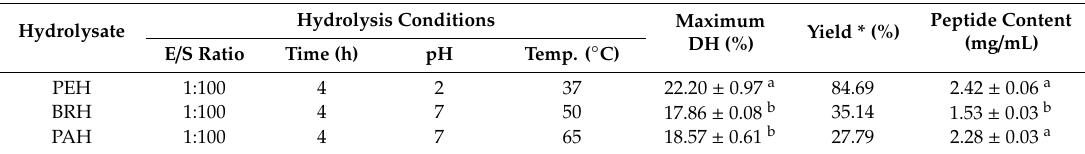
Table 3. Hydrolysis conditions, yield, and peptide content of C. angulata protein hydrolysate. PEH: pepsin hydrolysate; BRH: bromelain hydrolysate; PAH: papain hydrolysate. Hydrolysate